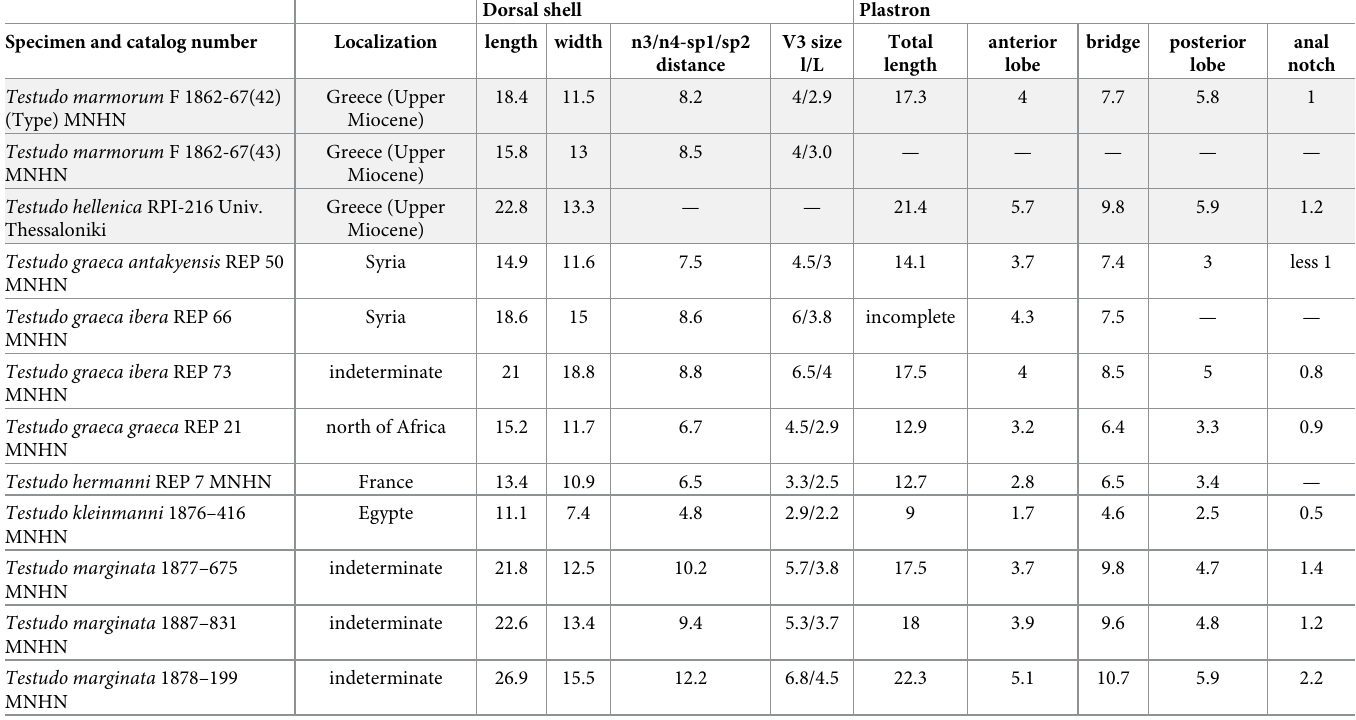
Table 2. Measurements of specimens analyzed and included in the comparative study. Fossil taxa are displayed on a grey background. Dorsal shell